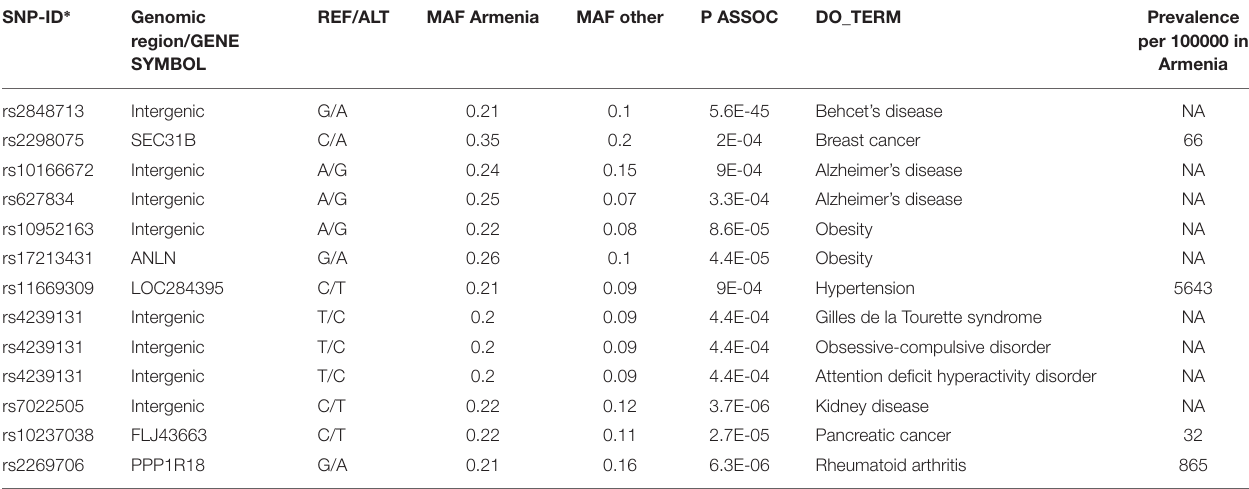
TABLE 1 | Top disease-risk associated SNPs in